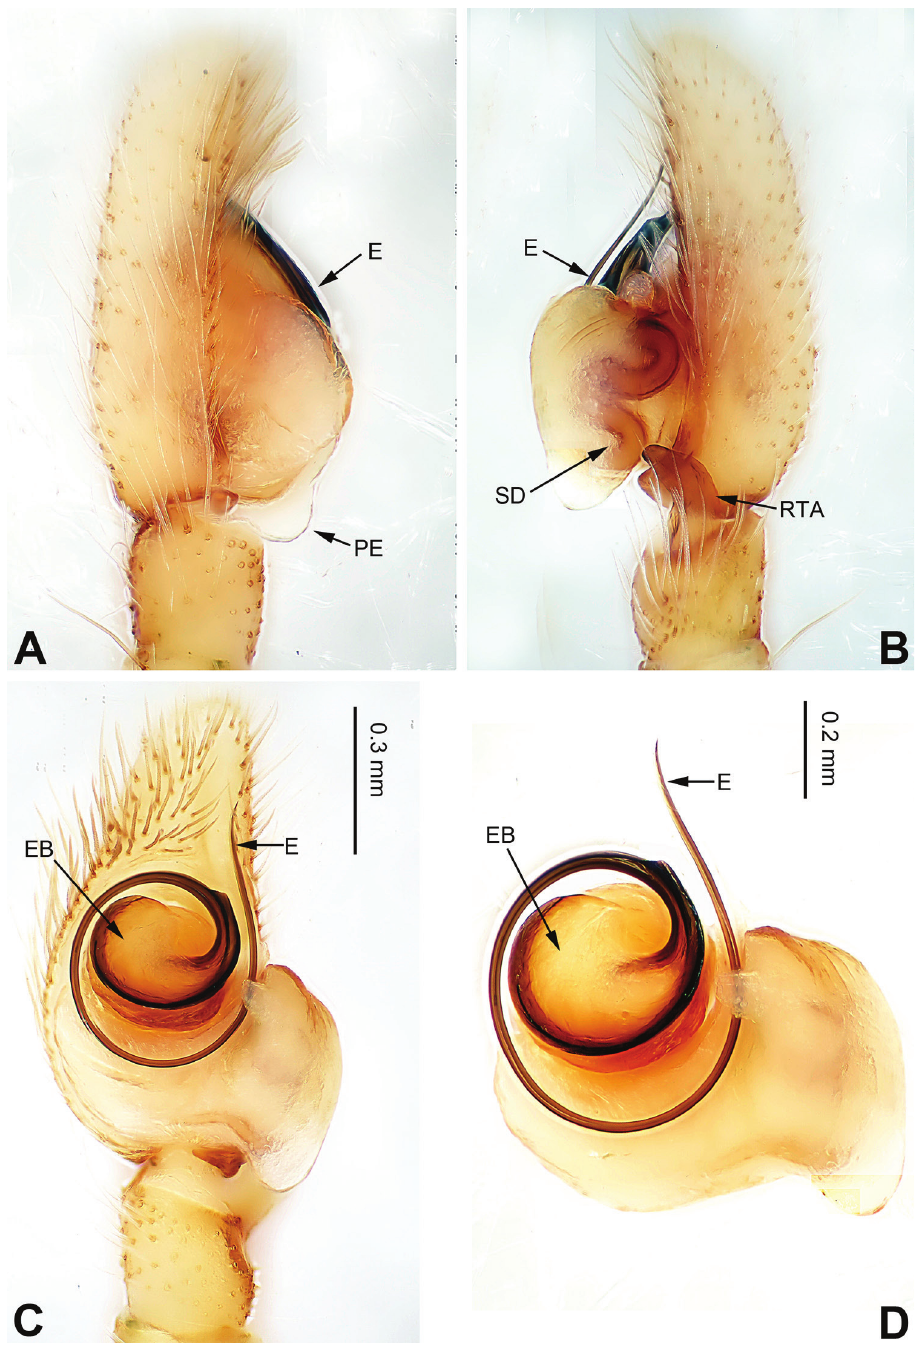
Figure 21. Palp of Cytaea yunnanensis sp. n., male holotype. A prolateral B retrolateral C ventral D bulb, ventral. Scale bar equal for A–C